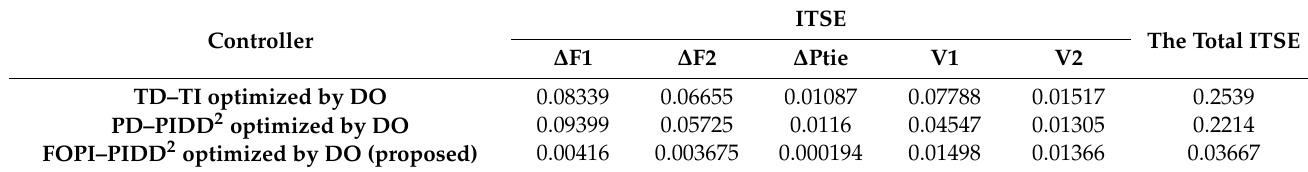
Table 6. Dynamic speci fi cations of the investigated system represented as ITSE value using di ff erent controllers under scenario 4